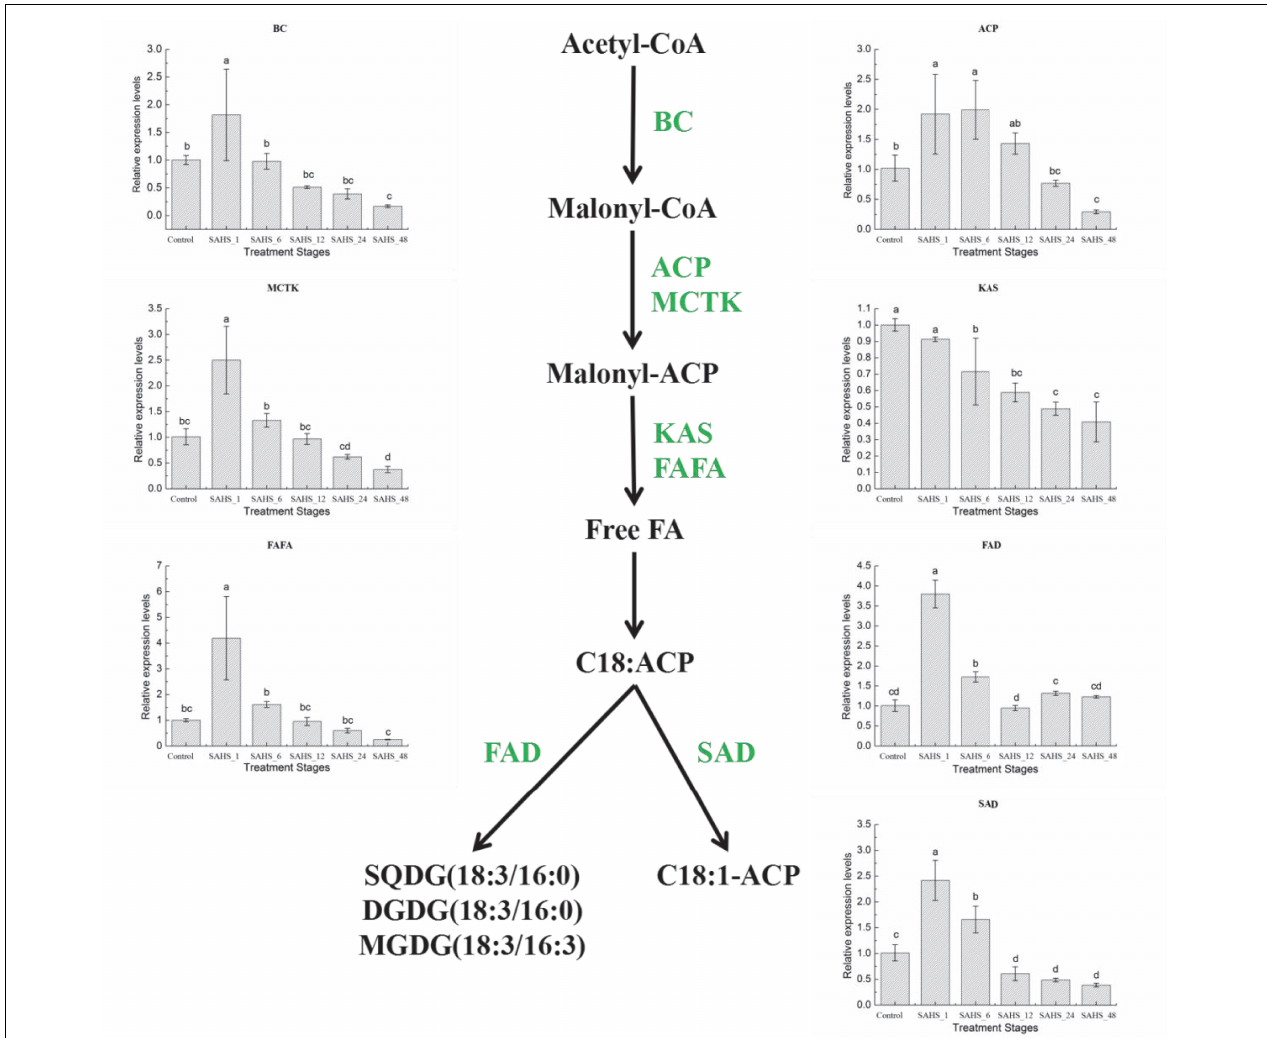
FIGURE 5 | Expression of genes in the H. pluvialis fatty acids biosynthesis pathway under different treatment stages. Lower case letters indicate significant differences ( p < 0.05) among the